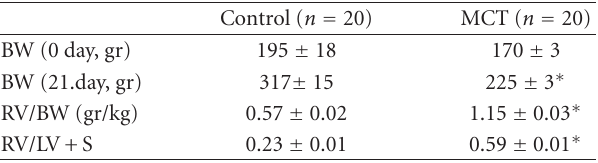
Table 1: E ff ects of monocrotaline treatment on rat body weight Table 2: Monocrotaline-induced morphometric changes in pul- and cardiac weight. Results are expressed as mean ± s.e.mean. monary arteries. Results are expressed as mean ± s.e. mean. ∗ Significantly di ff erent from control rat at P < 0 . 05. Number ∗ Significantly di ff erent from control rat at P < 0 . 05. Number of of animals is indicated in parentheses. BW (0 days): body weight animals is indicated in parentheses. WT: media wall thickness; ED: before injection; BW (21. day): body weight at 21 days after external diameter. injection; LV+S: wet weight of left ventricle plus septum; RV, wet weight of right ventricle; RV/ LV+S: ratio of RV to LV + S. Control ( n = 20) MCT ( n = 20) BW (0 day, gr) 195 ± 18 170 ± 3